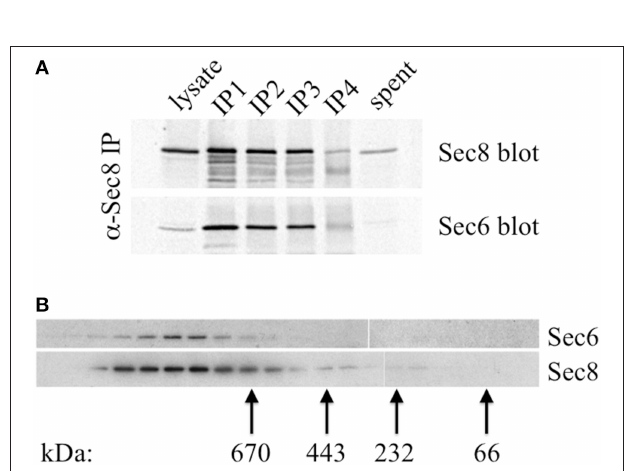
FIGURE 10 | Sec6 is quantitatively associated with Sec8 in high molecular weight complexes in MDCK cells. (A) All endogenous Sec6 is bound to Sec8. MDCK RIPA extracts were immunoprecipitated 4 times with anti-Sec8-bound protein A sepharose. Input lysate represents 10% of starting material. Depleted lysate (“spent”) represents 50% of the final post-immunoprecipitation supernatant. Samples were resolved by SDS-PAGE and immunoblotted with anti-Sec8(8F12) and anti-Sec6(10D11) antibodies. (B) Detergent extracts of polarized MDCK cells were fractionated by Superose 6 FPLC as described in Experimental Procedures. Fractions 9–27 were divided into equal aliquots, separated by SDS-PAGE, and transferred to Immobilon P membranes. Membranes were probed with anti-Sec8(8F12) and anti-Sec6(10D11) antibodies. Elution peaks of globular protein standards with known molecular weights were also determined: thyroglobulin, Mr = 669,000 (fraction 16); apoferritin, Mr = 443,000 (fraction 19); catalase, Mr = 232,000 (fraction 22); bovine serum albumin, Mr = 66,000 (fraction 25).